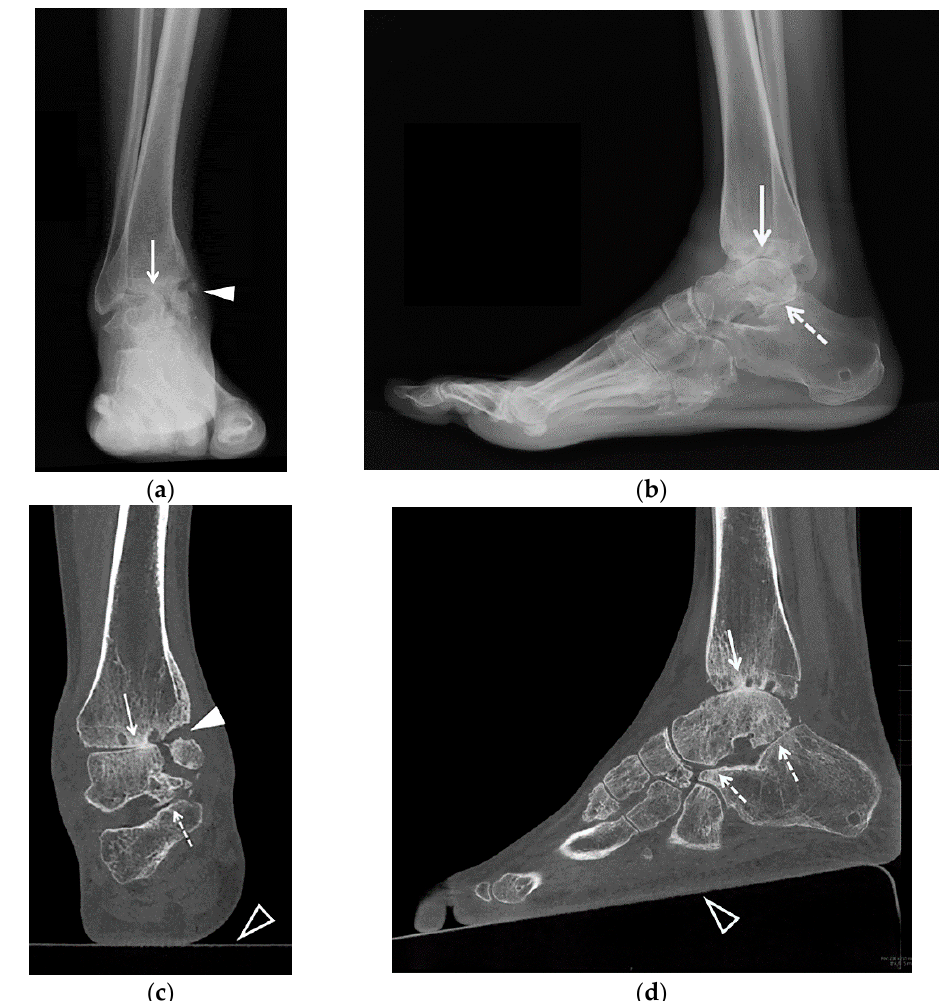
Figure 1. ( a – d ). A 25-year-old female with posttraumatic osteoarthritis of the right tibiotalar and subtalar joints. AP ( a ) and lateral ( b ) weight bearing radiographs and coronal ( c ) and sagittal ( d ) reformatted weight bearing CT images of the right ankle show an ununited medial malleolus fracture (arrowheads) and severe osteoarthritis of the tibiotalar (arrows) and subtalar joints (dashed arrows) with asymmetric joint space narrowing, subchondral sclerosis and small cyst-like changes. In ( b ) note the external fixator pin track in the calcaneal tuberosity. In ( c , d ) note a platform underneath of the foot (open arrowheads) with the CT images acquired in a cone-beam CT scanner dedicated to extremity imaging that allows the assessment of the alignment. Case courtesy of Imran Omar MD, Chicago, IL.